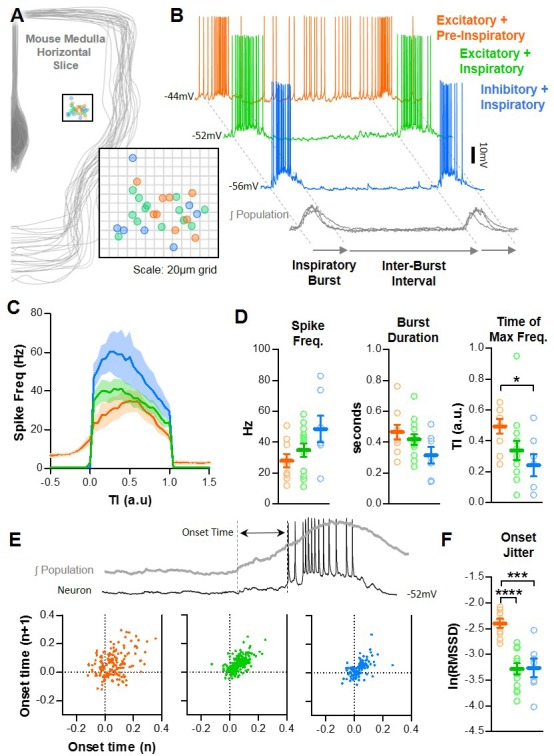
Baseline spiking patterns of excitatory and inhibitory neurons in the preBötC.(A) Anatomical locations of n = 29 recorded preBötC neurons. (B) Example traces of an excitatory neuron with pre-I spiking (orange) and without pre-I spiking (green) and an inhibitory neuron (blue) during the inspiratory burst and inter-burst interval (IBI). (C) Quantified spike frequency as a function of time (normalized to burst duration) from n = 9 pre-I excitatory, n = 13 non pre-I excitatory, and n = 7 inhibitory neurons. (D) Quantified mean spike frequency, duration, and shape of inspiratory bursts generated by each type of neuron (one-way ANOVA with Bonferroni post hoc tests). (E) Example quantification of neuronal burst onset time relative to the preBötC population and Poincaré plots showing onset time variability from n = 9 pre-I excitatory, n = 13 non pre-I excitatory, and n = 7 inhibitory neurons (20 inspiratory bursts/neuron). (F) Burst onset time variability or ‘jitter’ quantified as the natural log of the root mean square of successive differences (one-way ANOVA with Bonferroni post hoc tests). Data available in Figure 2—source data 1.